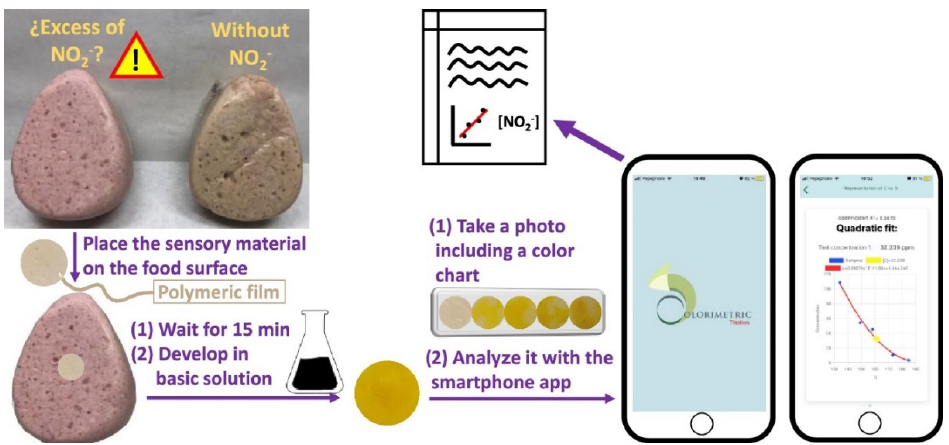
Figure 7. Measurement of the nitrite concentration in food samples using a sensory film-shaped polymeric film and analyzing the color change related to the amount of nitrite powered by the smartphone application Colorimetric Titration. Figure by Marta Guembe-García et al. from [109], licensed under CC BY 4.0 .